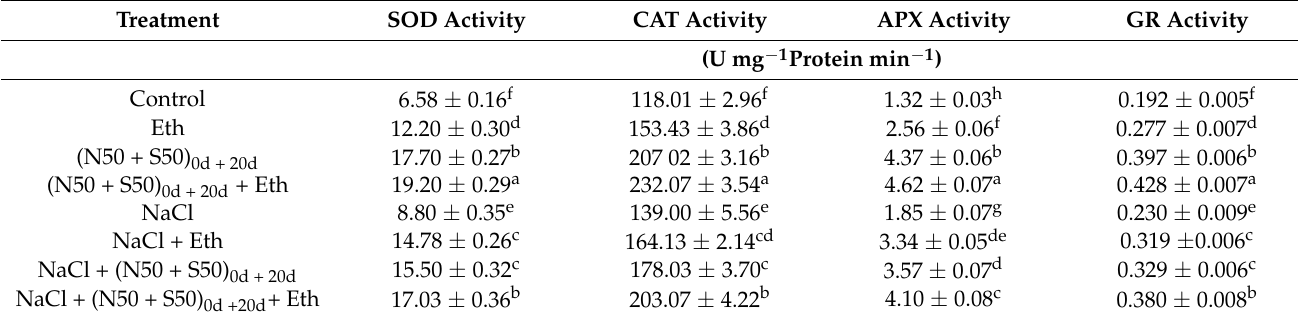
Table 2. The antioxidant enzyme activity of superoxide dismutase (SOD), catalase (CAT), ascorbate peroxidase (APX), and glutathione reductase (GR) reduced glutathione (GSH) content and redox state in mustard at 40 DAS. Plants were raised with split dosage of N and S (50 + 50 mg kg − 1 soil) at sowing time (0 DAS) and at 20 DAS and treated with 200 µ L L − 1 ethephon (Eth) in the absence or presence of 100 mM NaCl. Values are presented as means ± SE ( n = 4). Data followed by the same letter are not significantly different by LSD test at p < 0.05. DAS: days after sowing. Treatment SOD Activity CAT